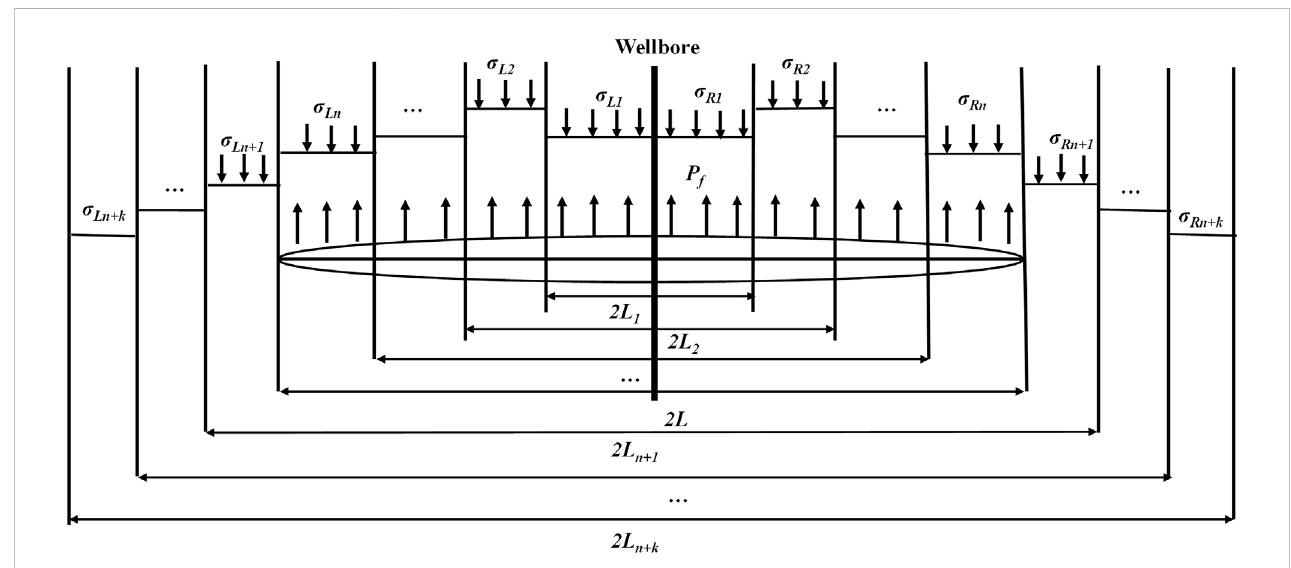
FIGURE 2 Schematic diagram of stress distribution along and beyond the fracture length.